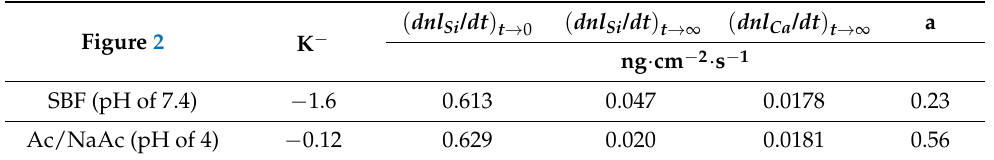
Figure 8. Silicon released from Vitryxx glass in the SBF (black squares) and in an aqueous solution at a pH of 4 (red squares). Lines represent the fit of nl(Si) = f(t) with empirical Equation (2). Table 5. Summary of parameters for the calculation of the overall dissolution rates ( a ) of the tested glass in selected fluids.